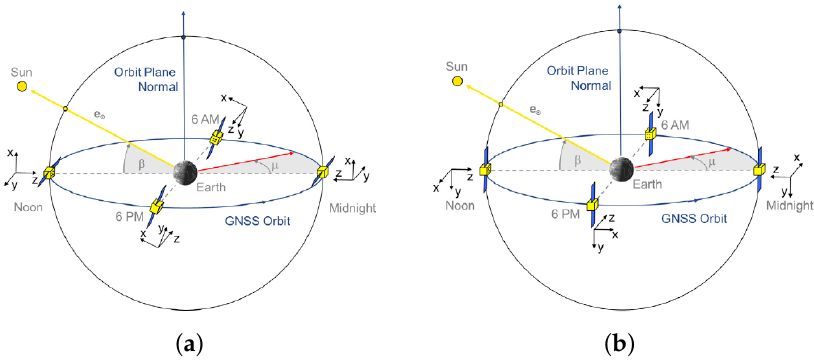
Figure 10. The attitude mode diagram of research objects (Reprinted with permission from Ref. [38], 2022, Yuchen Jiang): ( a ) Object 1; ( b ) Object 2.